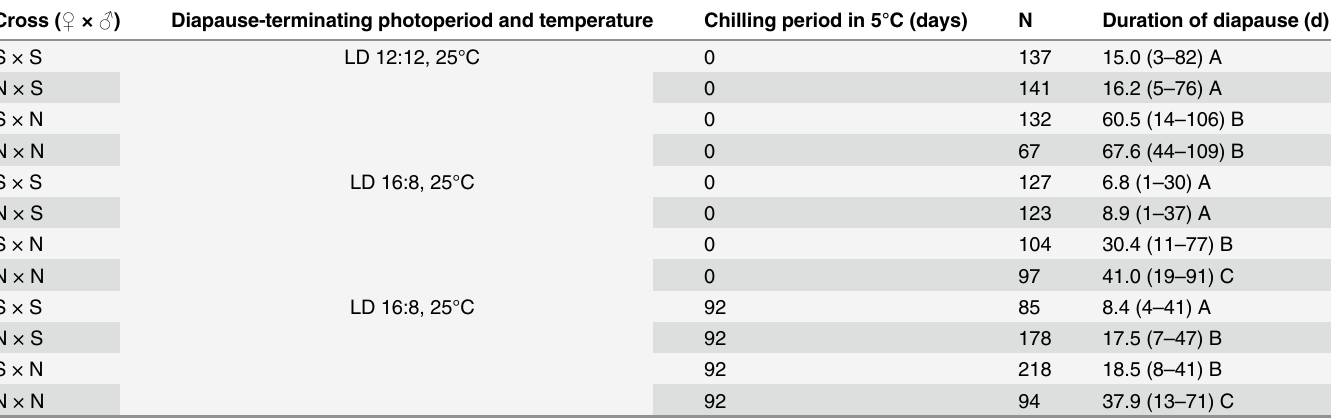
Diapause individuals were induced under LD 12:12 at 22°C, and then put under different conditions to terminate diapause 45 days after hatching. N, the northernmost Harbin strain; S, the southernmost Ledong strain. a Data are shown as the median (minimum-maximal value). Values followed by different letters are signi fi cantly different by Kruskal — Wallis test ( P = 0.0001 <